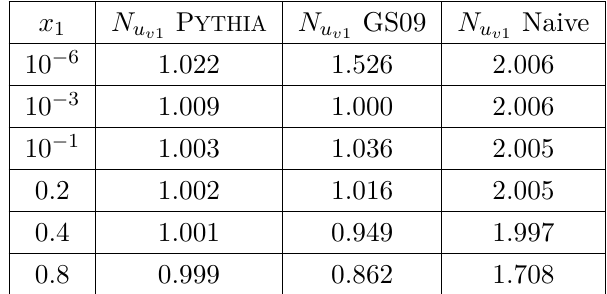
Table 1 . Numerical integration with respect to x 2 over R uu ( x 1 , x 2 , Q ) response function at fixed x 1 . Here N u stands for remaining number of valence u -quarks after the first hard interaction. In v 1 the ideal situation when the GS sum rules are perfectly satisfied N u